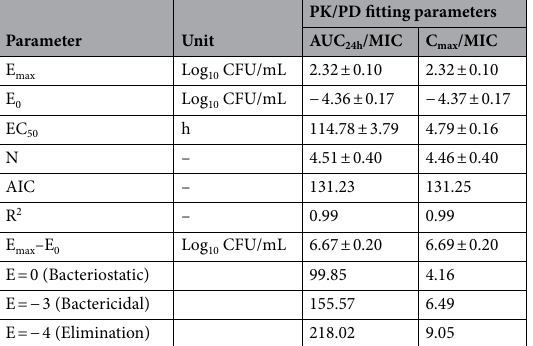
Table 5. The values of PK/PD parameters AUC 24h /MIC and C max /MIC required to achieving various levels of antibacterial effect of DAN. E 0 and E max are the changes in log 10 difference in bacterial count between 0 and 24 h in the control sample and in the DAN containing samples, respectively; EC 50 is the AUC 24h /MIC or C max /MIC producing 50% of the maximal antibacterial effect; C is the AUC 24h /MIC or C max /MIC in the effect compartment; N is the Hill coefficient, which describes the steepness of the (AUC 24h /MIC)-effect curve or C max /MIC-effect curve.